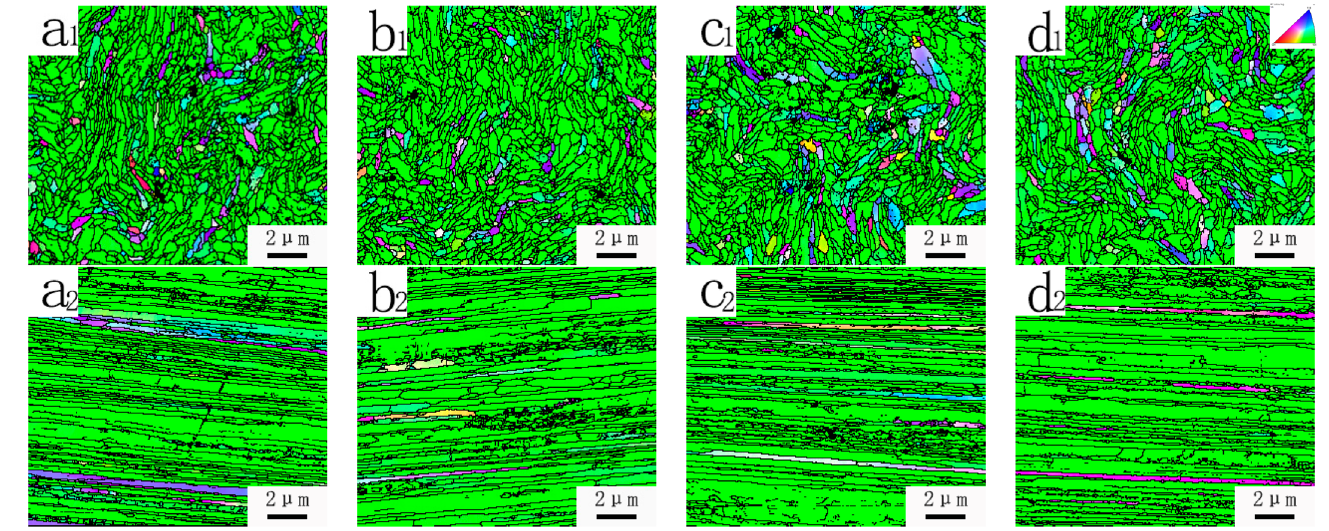
Figure 4. EBSD orientation maps ( a 1 , a 2 ) φ0.90 mm tungsten wire prepared by Process 1; ( b 1 , b 2 ) φ0.92 mm tungsten wire prepared by Process 2; ( c 1 , c 2 ) φ0.92 mm tungsten wire prepared by Process 3; ( d 1 , d 2 ) φ0.90 mm tungsten wire prepared by Process 4.